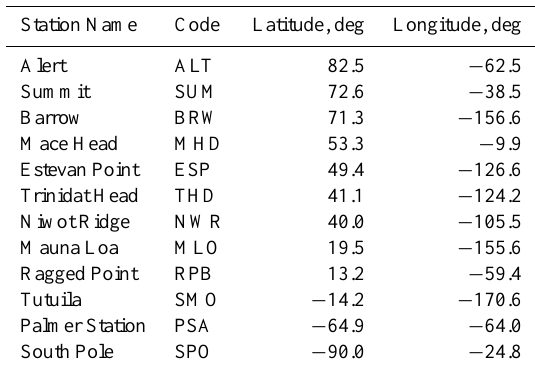
Fig. 4. Interhemispheric gradients of modeled and observed SF 6 concentrations. Observations are measurements taken from WD- CGG. The annual mean was normalized to its value at the South Pole (SPO) station.